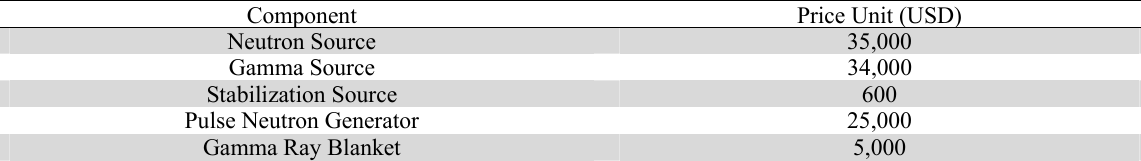
Cost for Saving Radioactive Source